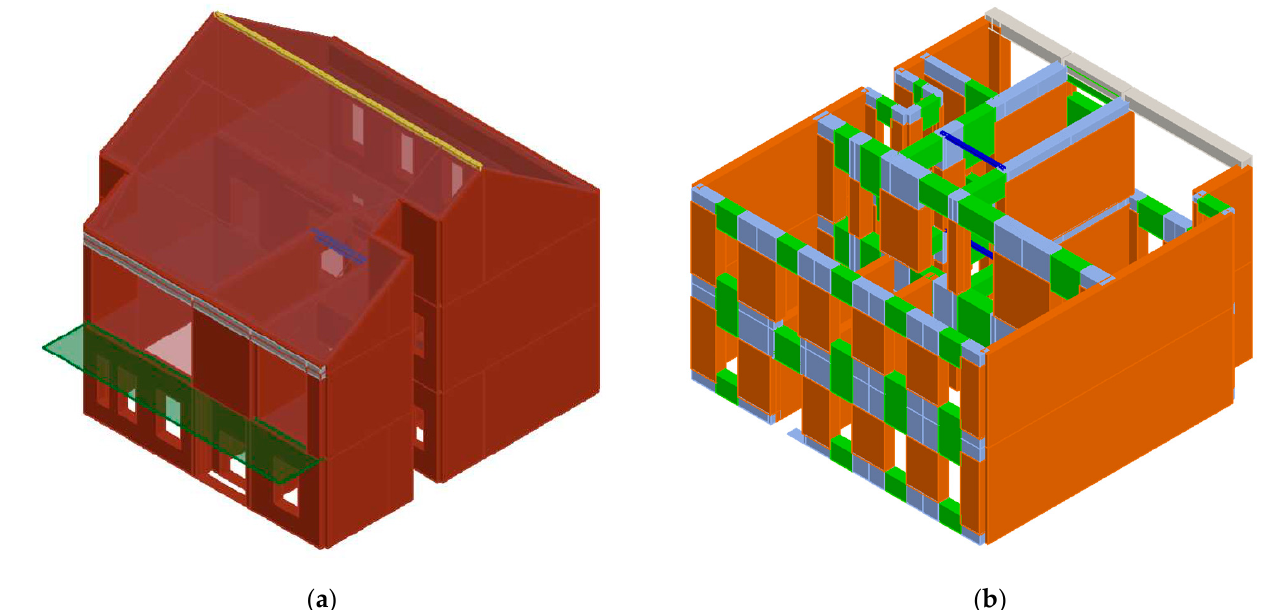
Figure 11. ( a ) The 3D model; ( b ) 3D equivalent frame of the elaborated building.